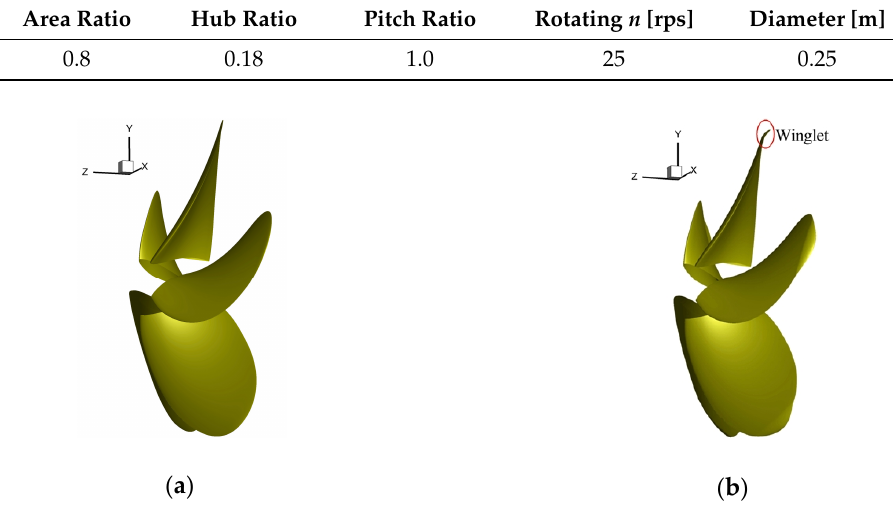
Figure 1. Propeller geometric model: ( a ) benchmark propeller and ( b ) the winglet-propeller, whose blade tips tilt toward the wake of the